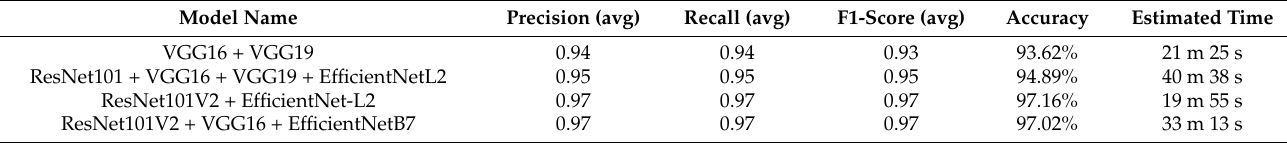
Table 3. Performance evaluation combined